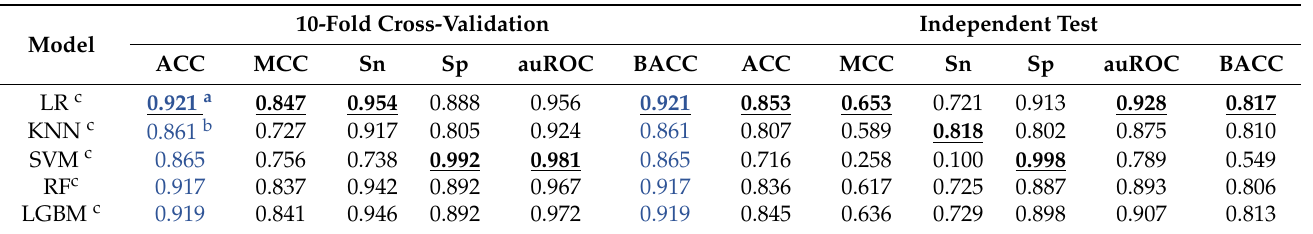
Table 1. Results of 10-fold cross-validation and independent testing based on the five ML algorithms developed using SMOTE-balanced features.